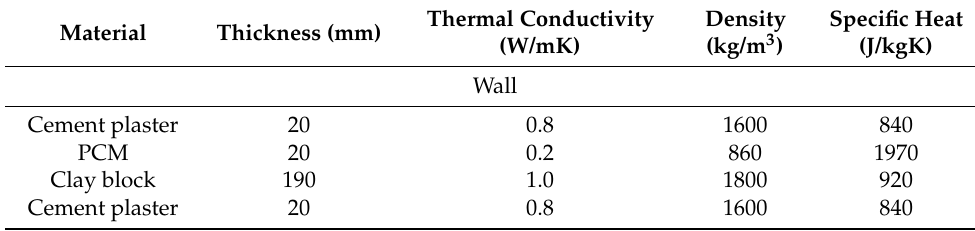
Table 1. Thermophysical properties of the wall composition [28,29].